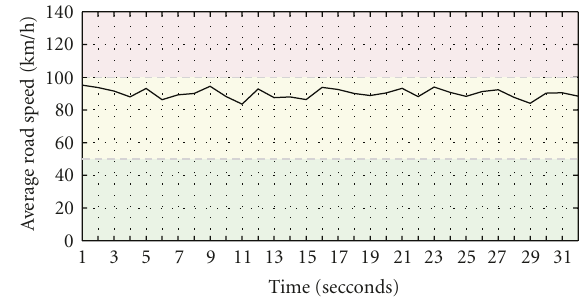
Figure 21: Average road speed at every second in a real